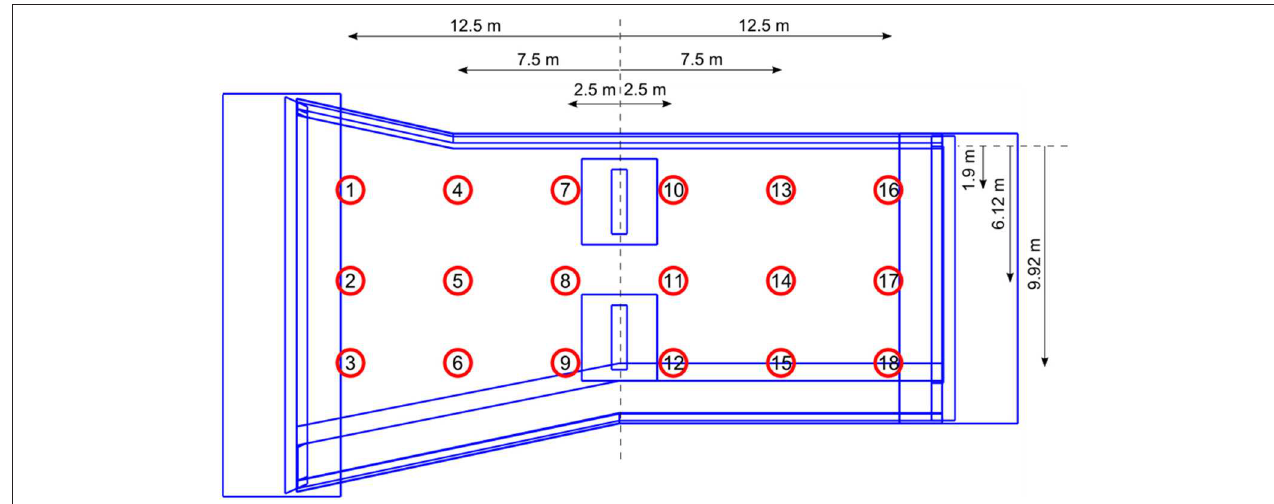
FIGURE 8 | Sensor network layout at the deck of the Bärenbohlstrasse overpass (Klis et al.,